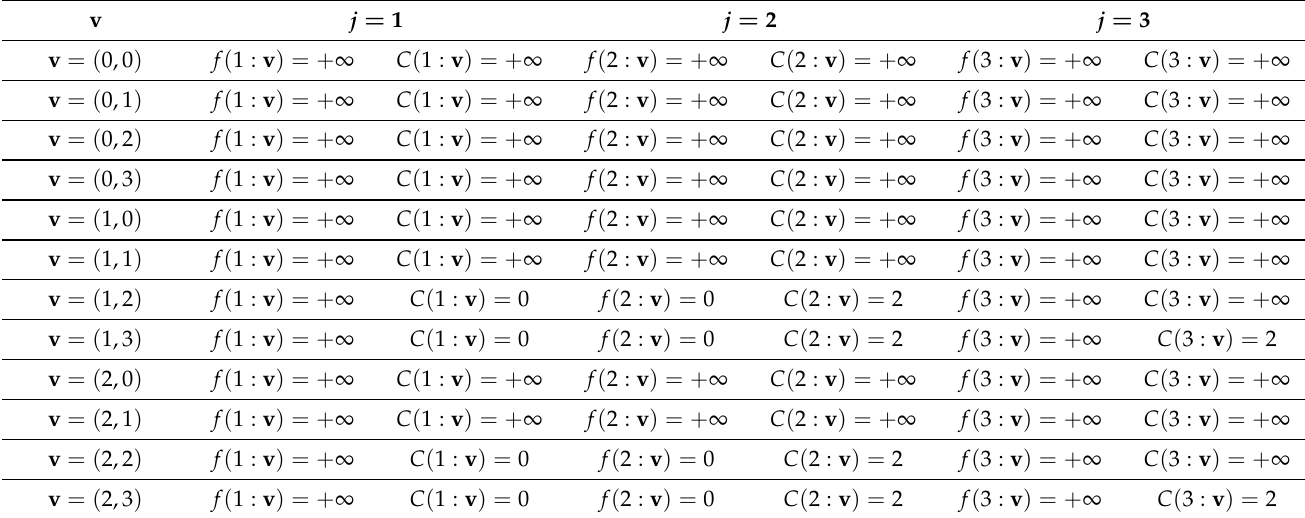
Table 4. The values of the recursion